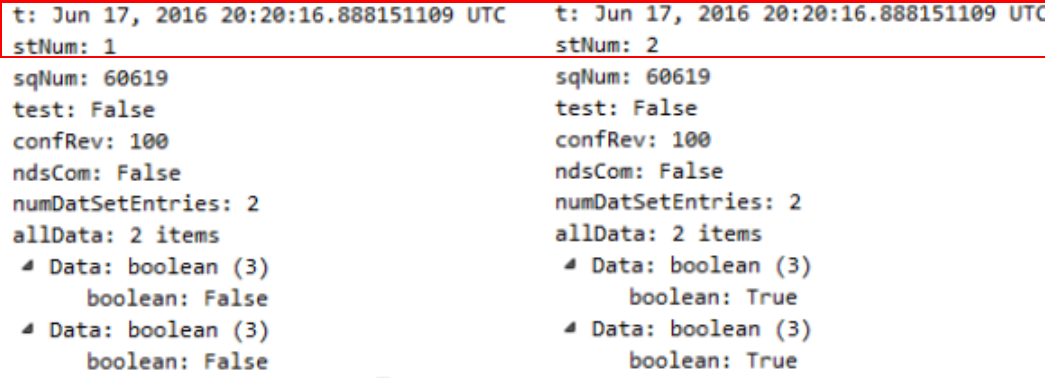
Figure 9. Wireshark Capture of Transmitted Messages with Same Time Stamp (t) and Incremented status number (stNum).